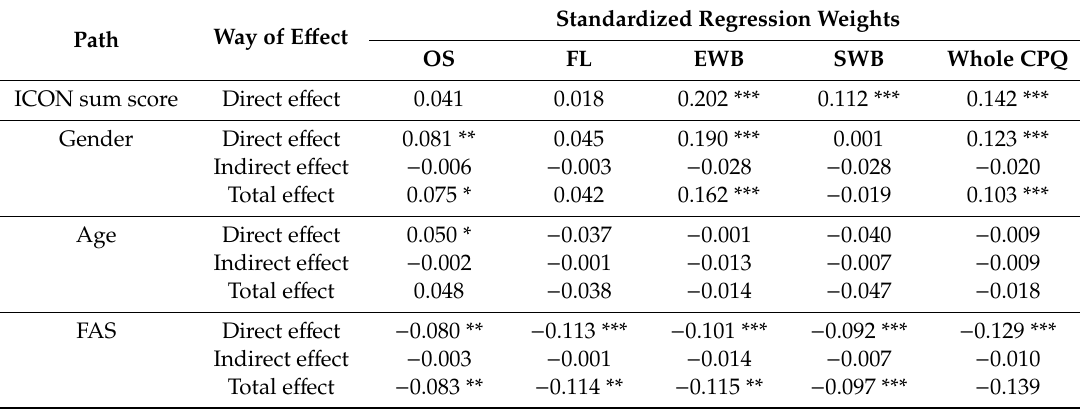
Table 5. Standardized direct, indirect and total e ff ects of ICON, gender, age, and family a ffl uence on the oral-health-related quality of life (OHRQoL), assessed in four domains and for the CPQ as a whole. Standardized Regression Weights Path Way of E ff ect OS FL EWB SWB Whole CPQ ICON sum